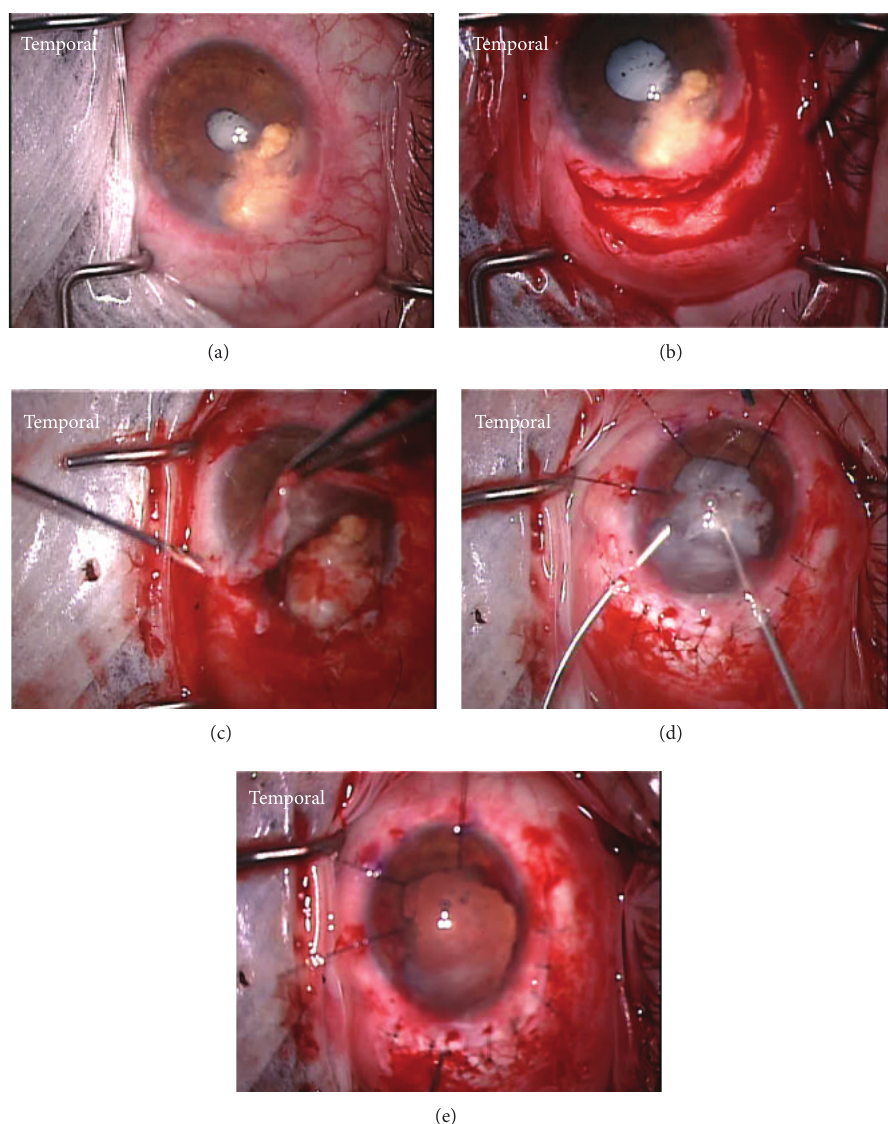
Figure 3: Steps of surgical procedure from case 1. (a) Intraoperative view of the iris implantation cyst along the inferotemporal iris. (b) A conjunctival peritomy and 180-degree scleral tunnel were fashioned along the temporal aspect of the cyst to facilitate access to and removal of the cyst. (c) The cyst was dissected from the posterior cornea using viscoelasticity. The cornea was then retracted to expose the cyst. Intraocular diathermy was applied along the iris adjacent to the cyst to reduce bleeding prior to performing a large sector iridocyclectomy. (d) The scleral incision was closed with nine 9–0 nylon sutures. After lysis of posterior synechiae, three iris hooks were used to retract the remaining iristissueandthecataract was removed with ananteriorvitrector. (e)Intraocular lensplacement wasdeferred atthetimeofsurgery until longer-term ocular stability could be demonstrated. The patient was left